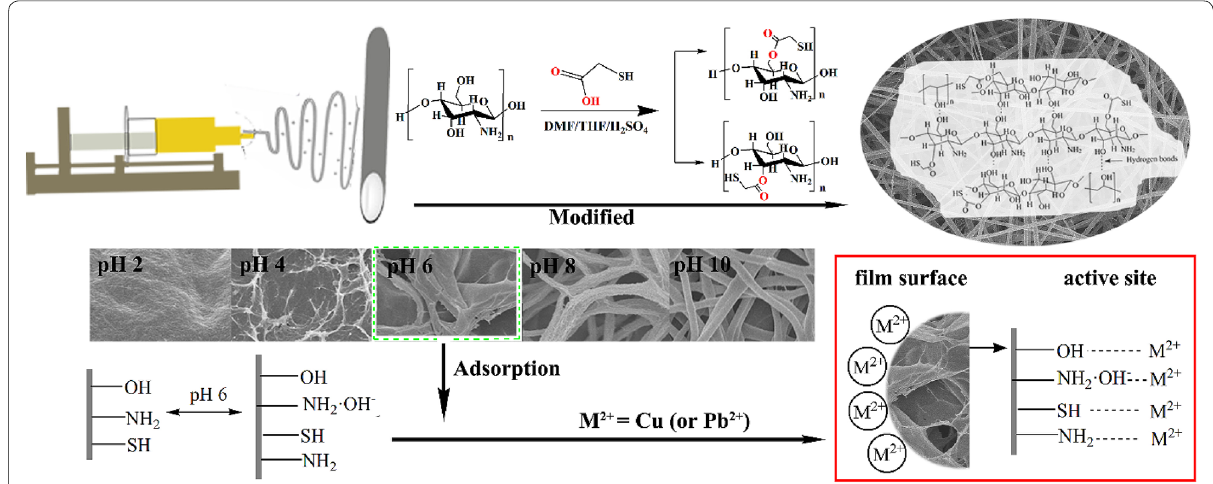
Fig. 10 Electrospinning CNC/CTS/PVA-SH composite nanofiber membrane. (Reprinted from